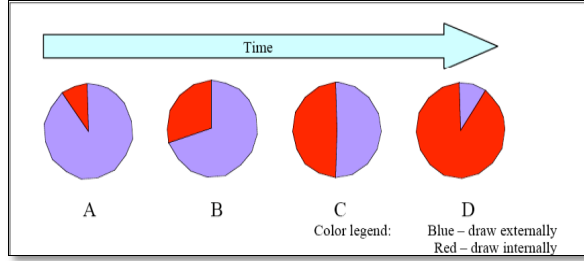
Figure 1. Evolution of a discipline from a reference discipline perspec- tive [15]